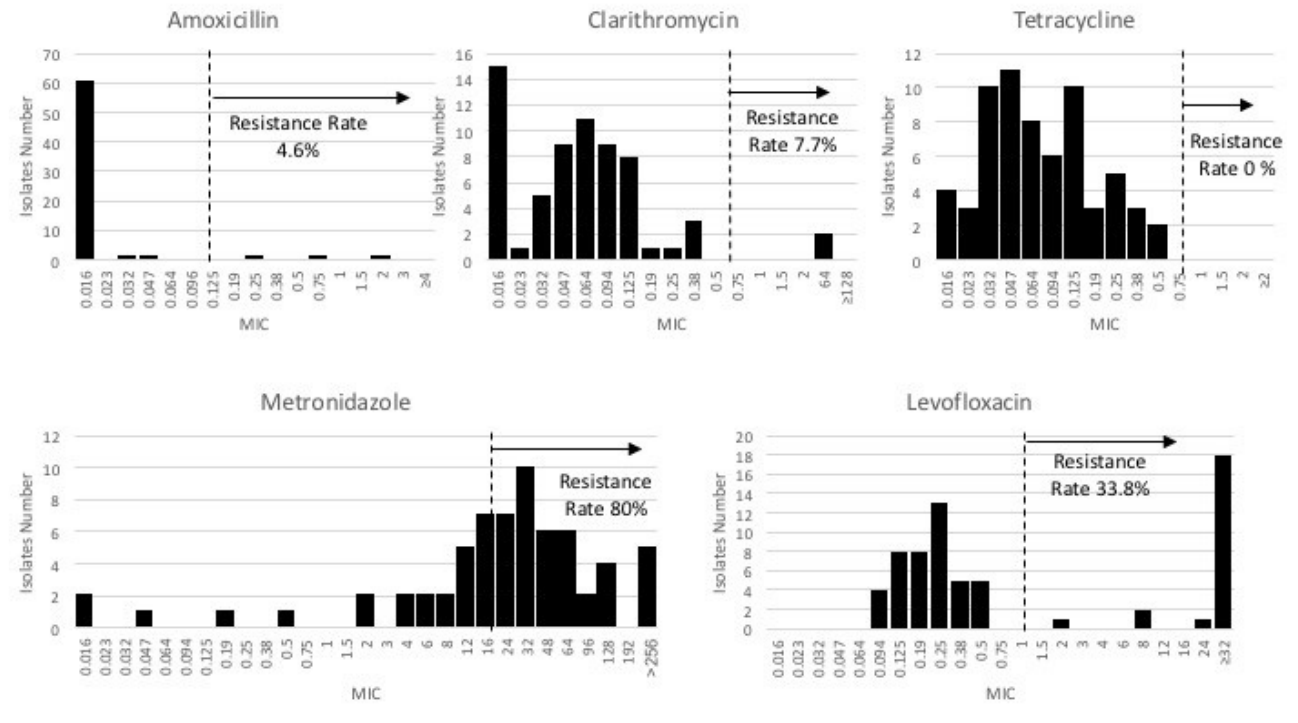
Figure 1. The five major antibiotic resistance rates of 65 H. pylori isolates from Myanmar. The clinical breakpoints were determined following the European Committee on Antimicrobial Susceptibility Testing (EUCAST; Clinical Breakpoint Table v. 5.0) criteria; MIC of >0.125 mg/L for AMX, >0.5 mg/L for CAM, >8 mg/L for MNZ, >1 mg/L for LVX, and >1 mg/L for